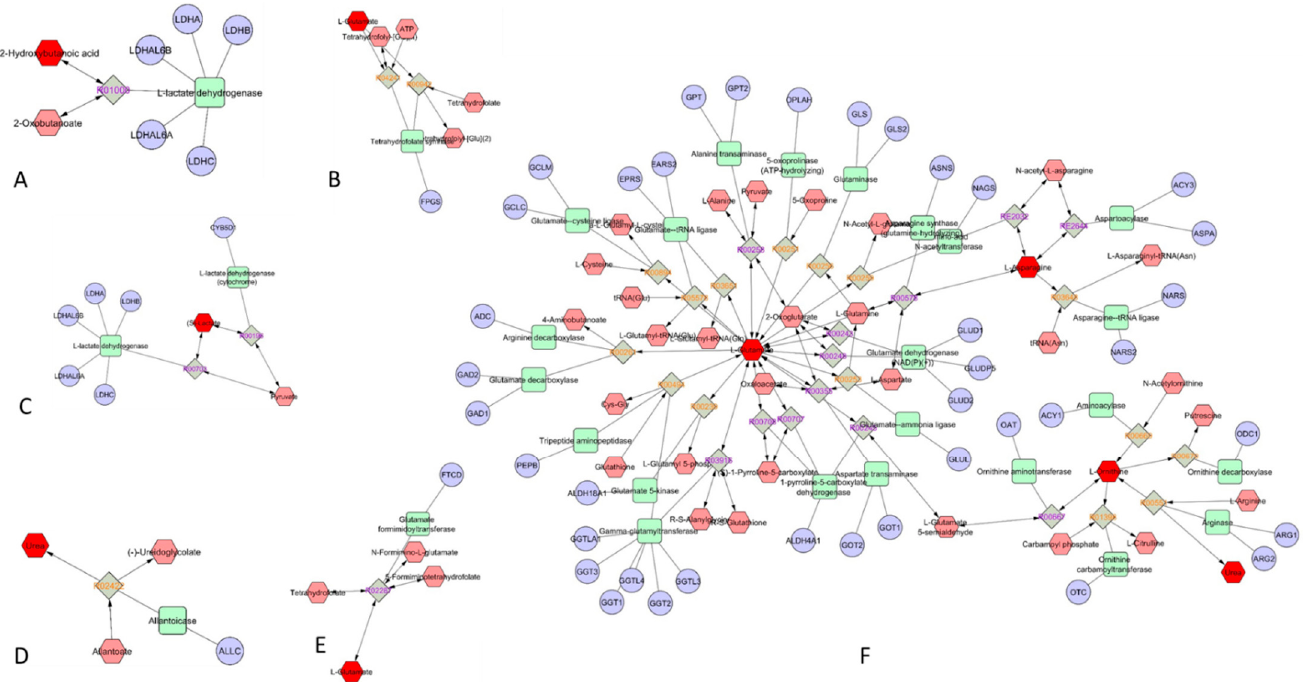
Figure 3. Selected interaction networks obtained using plasma metabolites identified by GC-MS showing a statistically significant increase/decrease in basketball players in comparison with controls (see Table 2). The network analysis was carried out by using the MetScape 3 App for Cytoscape (http://metscape.med.umich.edu accessed on 10 December 2020).